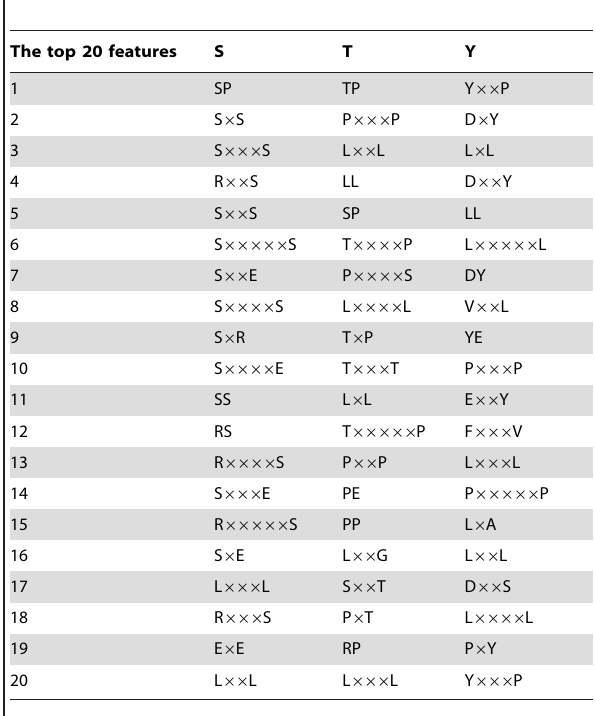
Table 3. The top 20 features ranked by IG based feature selection method.